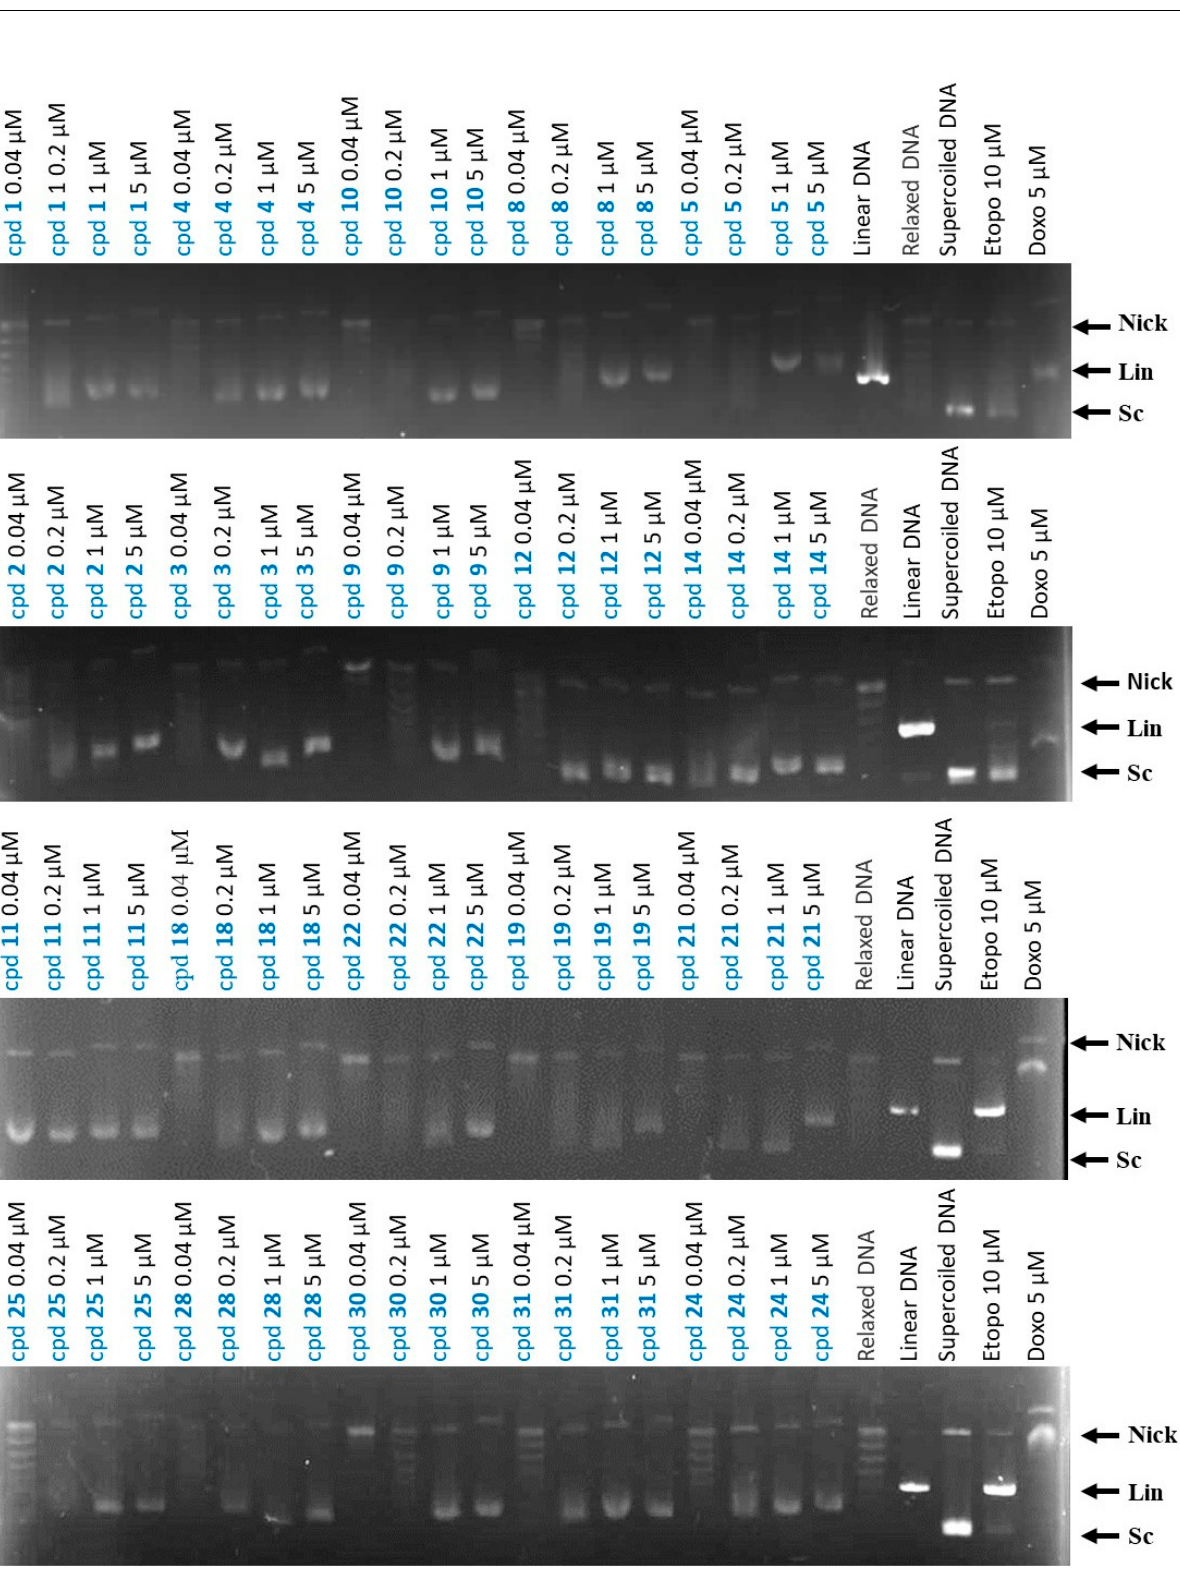
Figure 2 . Effects of compounds on topoisomerase II activity. Effects on Topo II-mediated relaxation of supercoiled pHOT1 plasmid DNA in a cell-free system. Positive control: etoposide (10 µ M); doxorubicin (5 µ M) used as Topo II poison (induction of linear DNA); DNA relaxation: plasmid DNA + topo II α + solvent control. Nick, nicked DNA; Sc, supercoiled DNA; Lin, linear